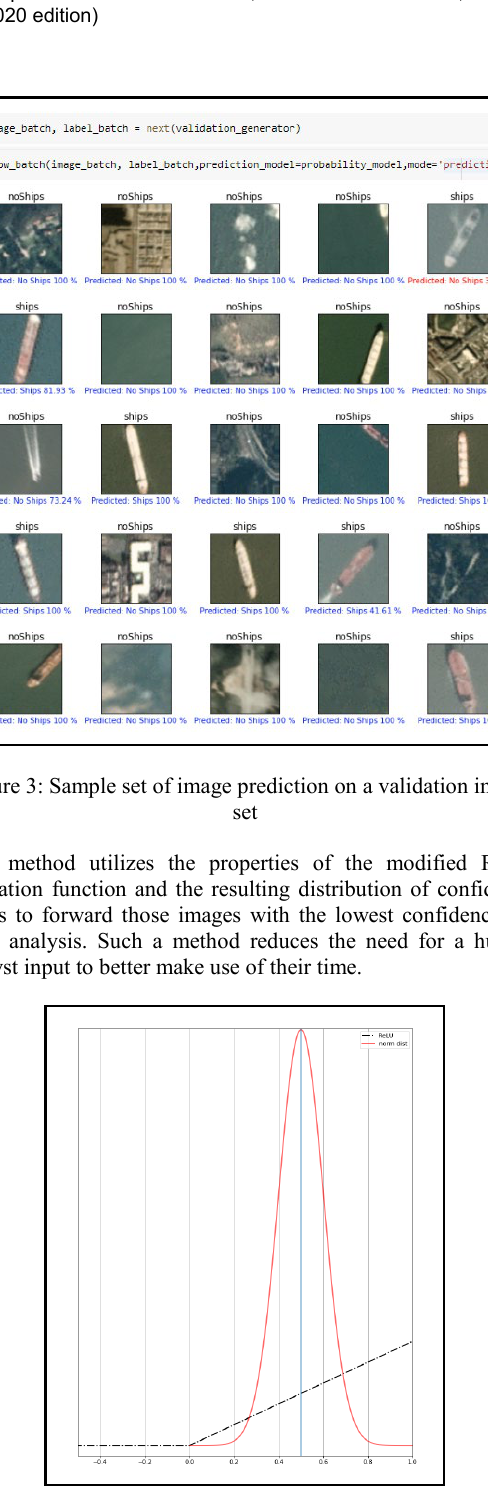
Figure 4. Modified ReLu activation function (y=max(0,x) where 0 1) and a normal distribution centered at ≦ ≦